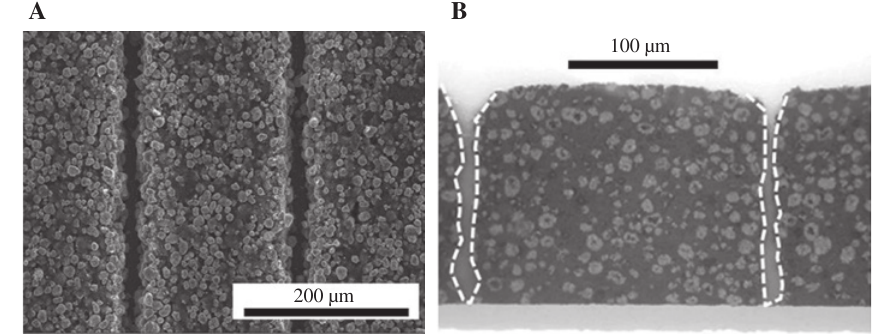
Figure 18: Laser structuring of NMC thick-film electrodes. (A) SEM image (top view) and (B) microscopy image (cross-section view) (film thickness: 155 μ m).